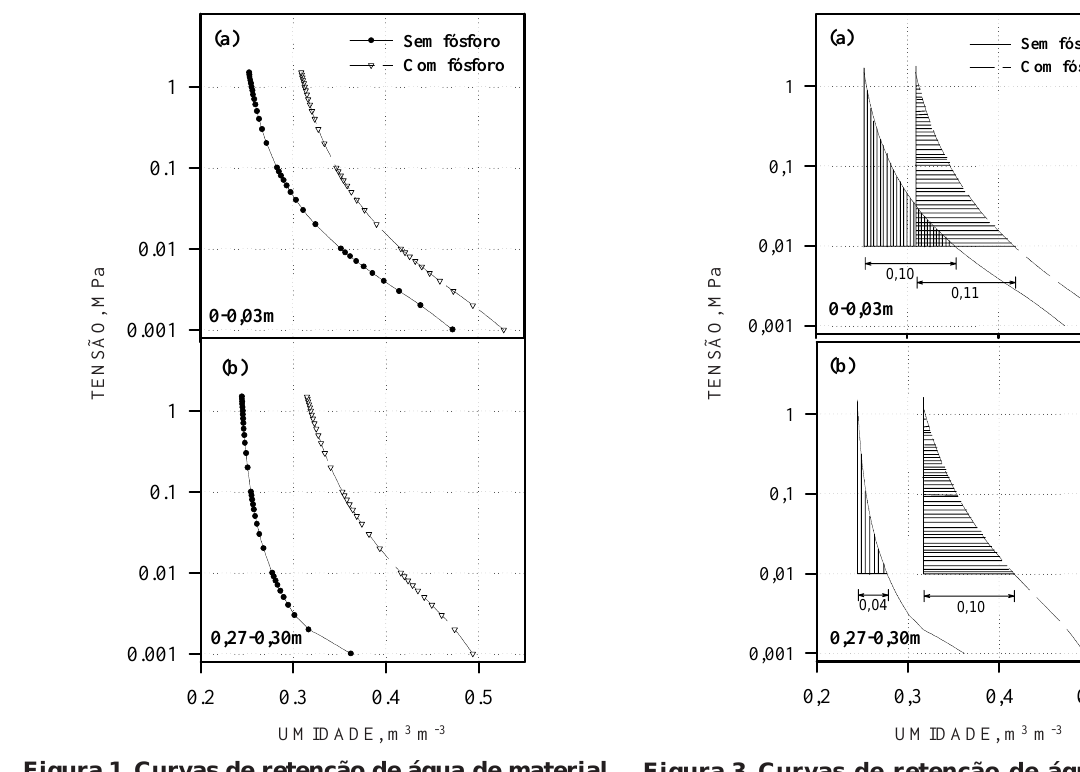
Figura 3. Curvas de retenção de água e os seus teores de água disponível, com e sem P, em duas camadas do